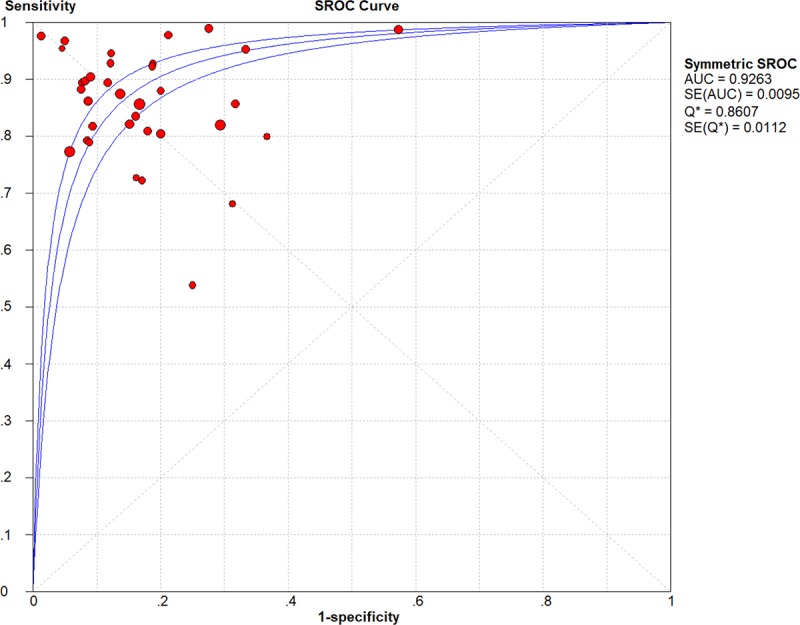
SROC curves of CEUS for characterizing thyroid nodules.